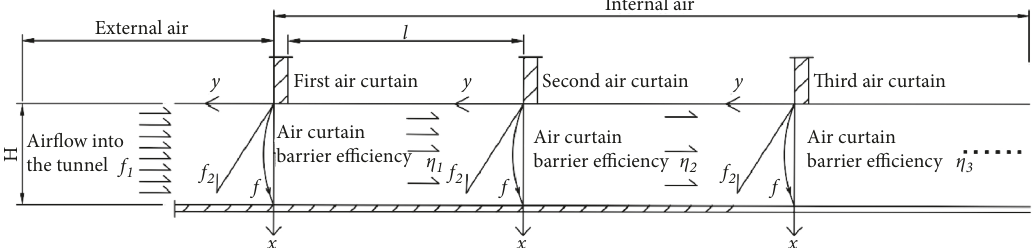
Figure 4: Calculation model of air curtain barrier efficiency.